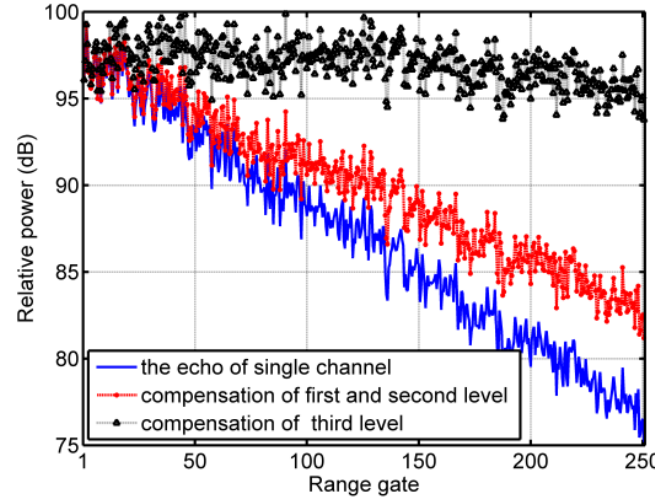
Figure 7. Example of the echo amplitude before and after echo amplitude is compensated.